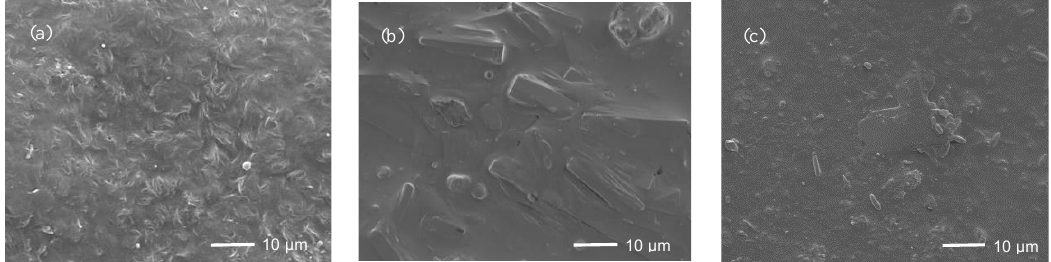
Figure 10. SEM images of the material samples immersed in the simulated leachate solution (pH = 4.0) for 14 days: ( a ) Original HDPE; ( b ) HDPE after immersion; ( c ) HPS5 composite.